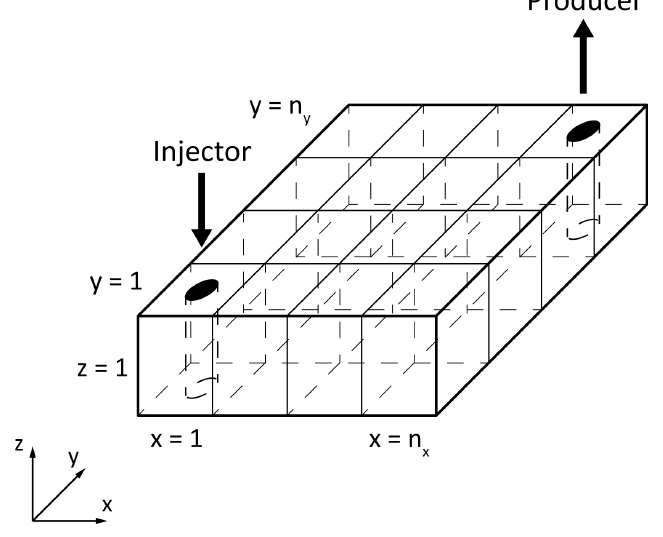
Figure 1. Schematic representation of the quarter 5-spot used for the